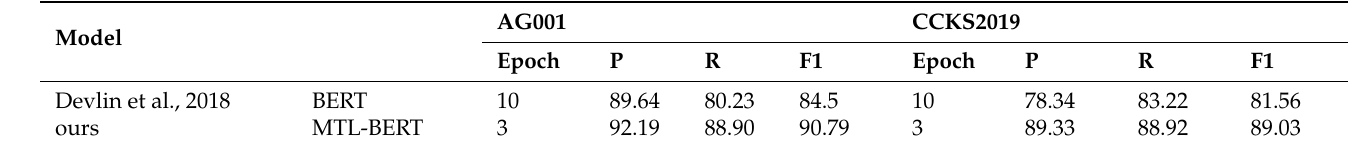
Table 5. Domain-specific Named Entity Recognition Comparison Experiment Results (%).